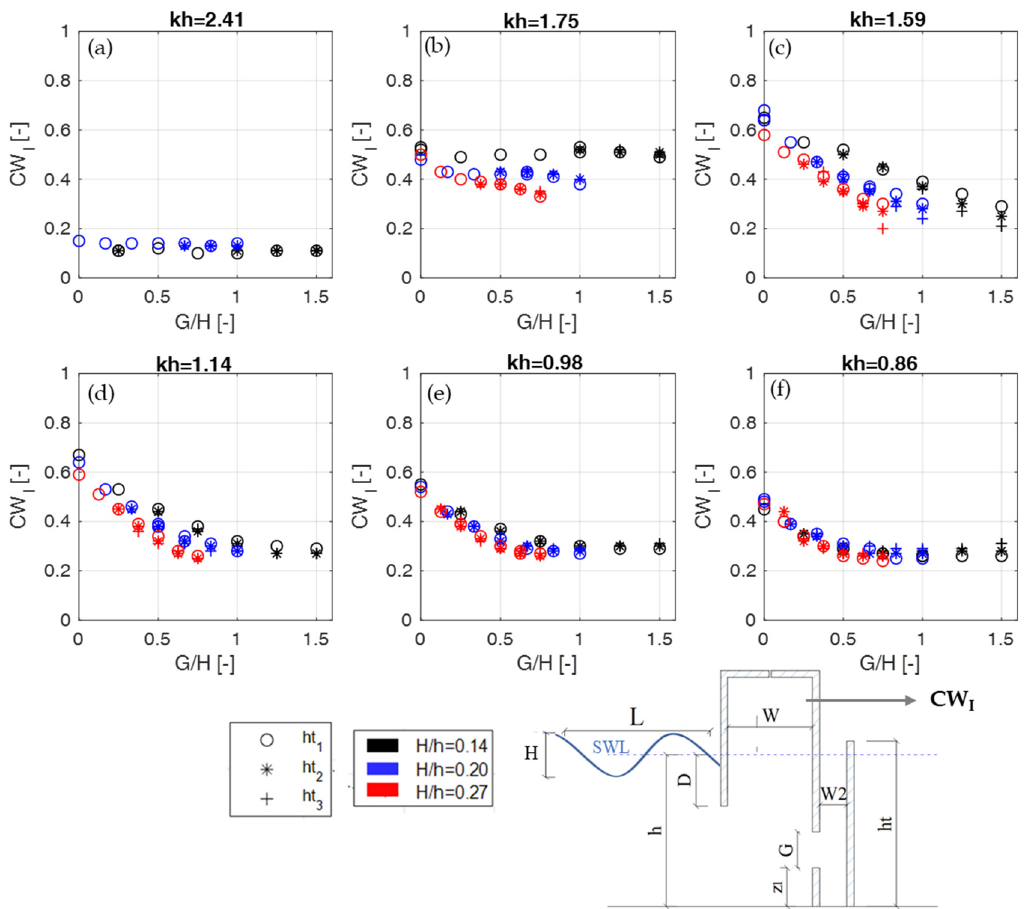
Figure 5. Capture width of the OWC chamber CW I as a function of the relative size of the submerged aperture G / H for different relative water depths: kh = 2.41 ( a ), 1.75 ( b ), 1.59 ( c ), 1.14 ( d ), 0.98 ( e ), 0.86 ( f ).